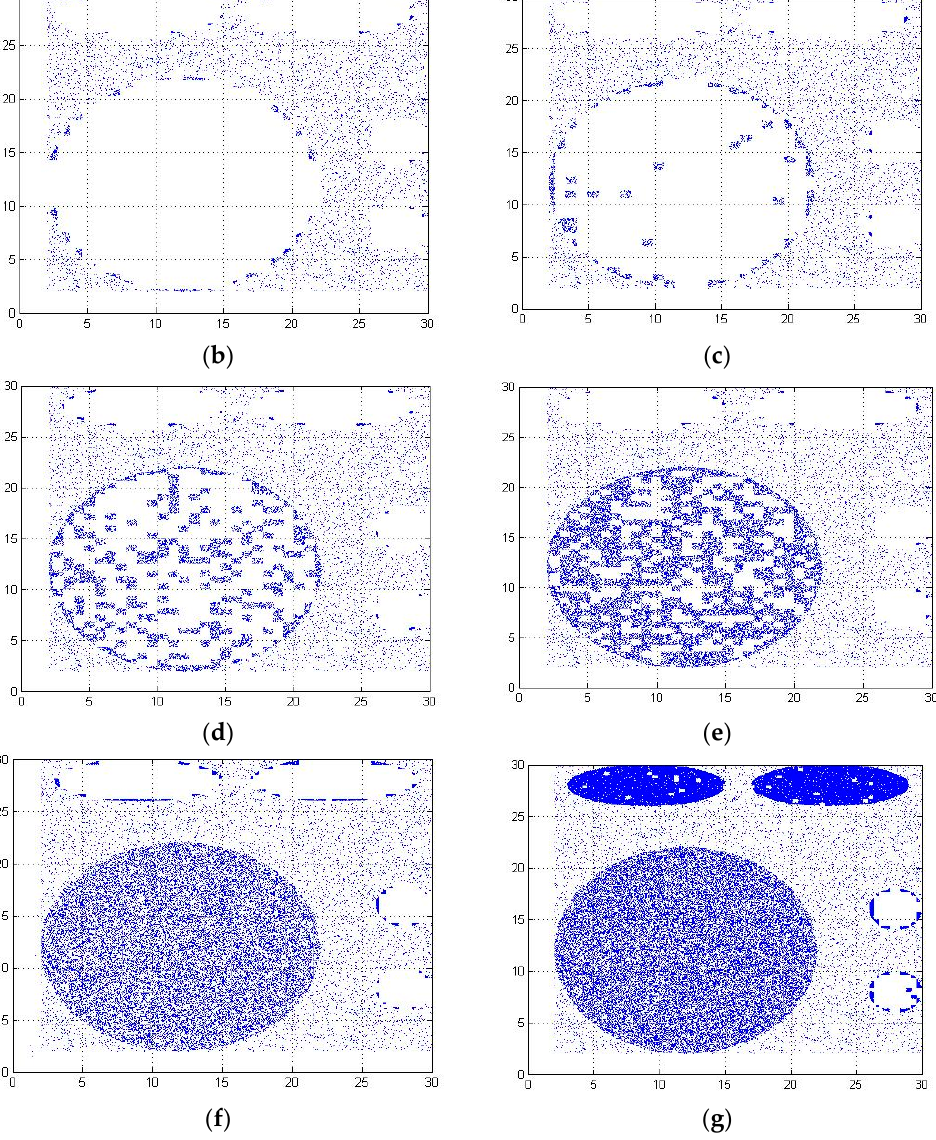
Figure 12. Experimental comparison of the effectiveness of our DOM method: ( a ) Distribution of the original dataset (|N| = 100,000); ( b ) dataset distribution after being partitioned by P,T (|N| = 4822); ( c ) dataset distribution after being partitioned by P,T (|N| = 6162); ( d ) dataset distribution after being partitioned by P,T (|N| = 14,010); ( e ) dataset distribution after being partitioned by P,T (|N| = 24,512); ( f ) dataset distribution after being partitioned by P,T (|N| = 31,523); ( g ) dataset distribution after being partitioned by P,T (|N| = 79,051).